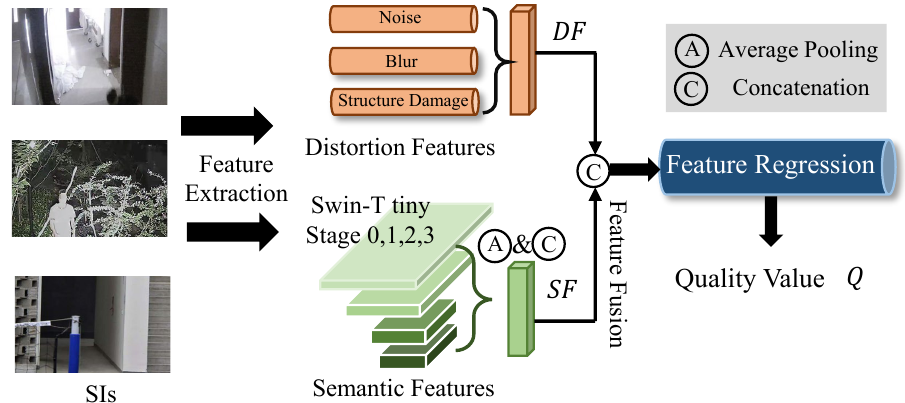
Figure 2. The framework of the proposed